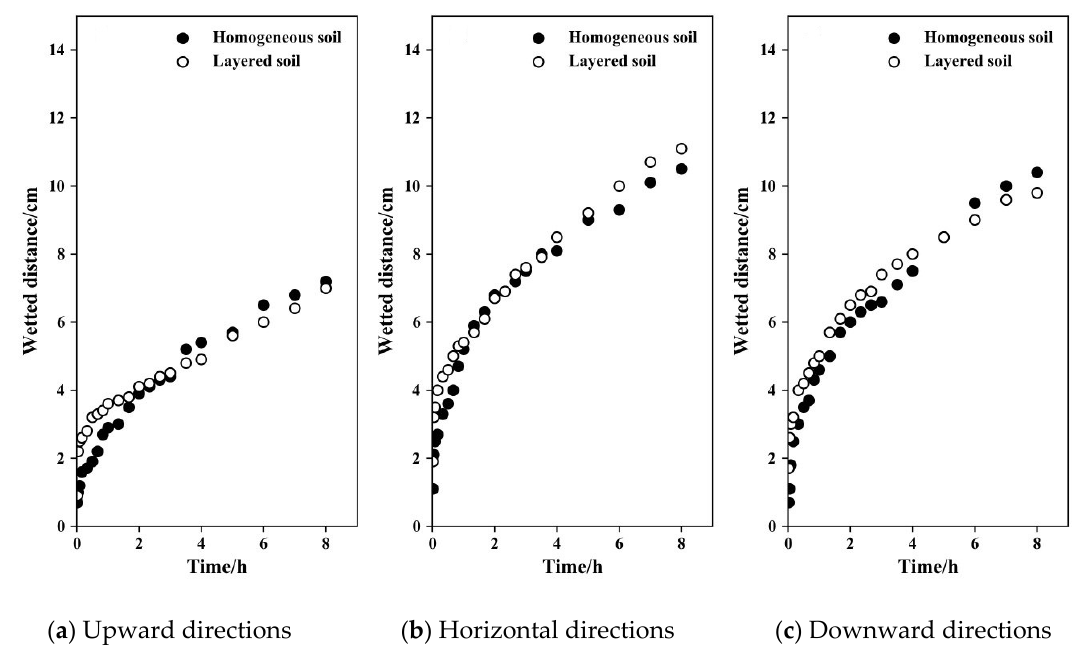
Figure 7. Evolution of maximum wetting front movement distance.